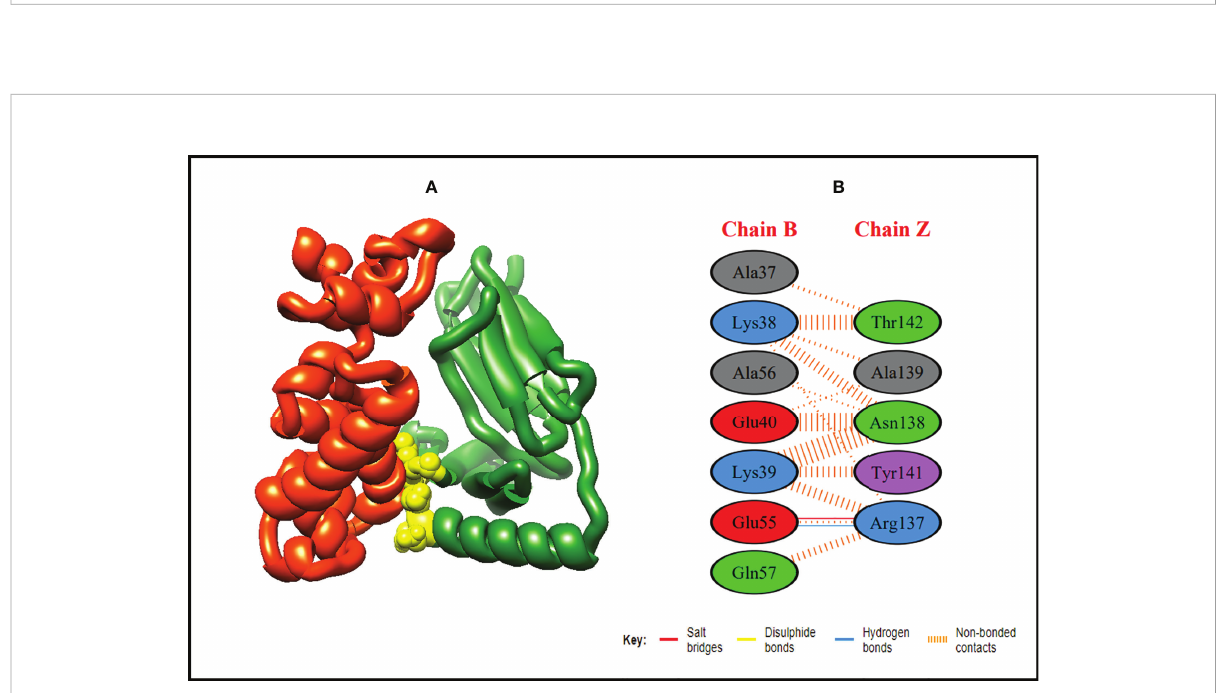
FIGURE 6 Schematic illustration of MEMPV-MHC II docked cluster. (A) Docked pose of MEMPV-MHC II docked cluster. Construct in orange-red, MHC II receptor in forest green and interacting residues between immune receptor and vaccine are shown in yellow color. (B) Dimplot of vaccine construct-MHC II docked